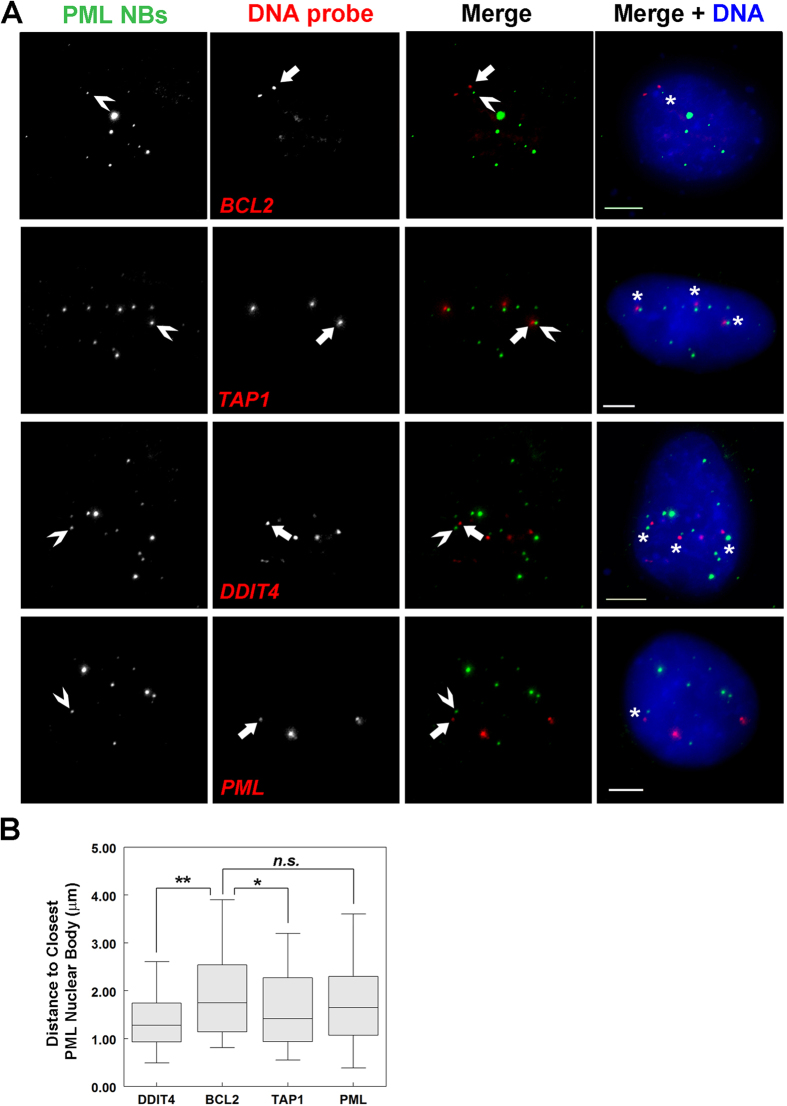
DDIT4 gene loci are proximal to PML NBs.(A) U2OS cells were fixed and prepared for 3D immuno-FISH. DNA probes (red) detect the genomic regions containing DDIT4, BCL2, TAP1 and PML; antibodies detect PML within the PML NBs (green), and DNA was visualized with DAPI (blue). In each panel, Arrows indicate the gene loci (red) in closest proximity to a PML NB (green) indicated by a chevron (>). *Gene loci within 2 μm of a PML NB. Scale bar = 5 μm. (B) Box and whisker plots showing the median and distribution of shortest Euclidean distances between indicated gene loci and the closest PML NB per cell (n = 50 nuclei). p-values < 0.01 (**) or <0.05 (*) and n.s. = not significant.